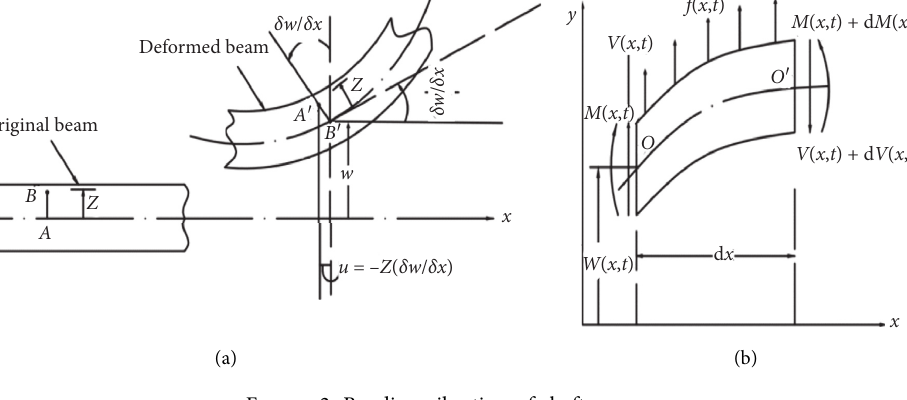
Figure 2: Bending vibration of shaft.